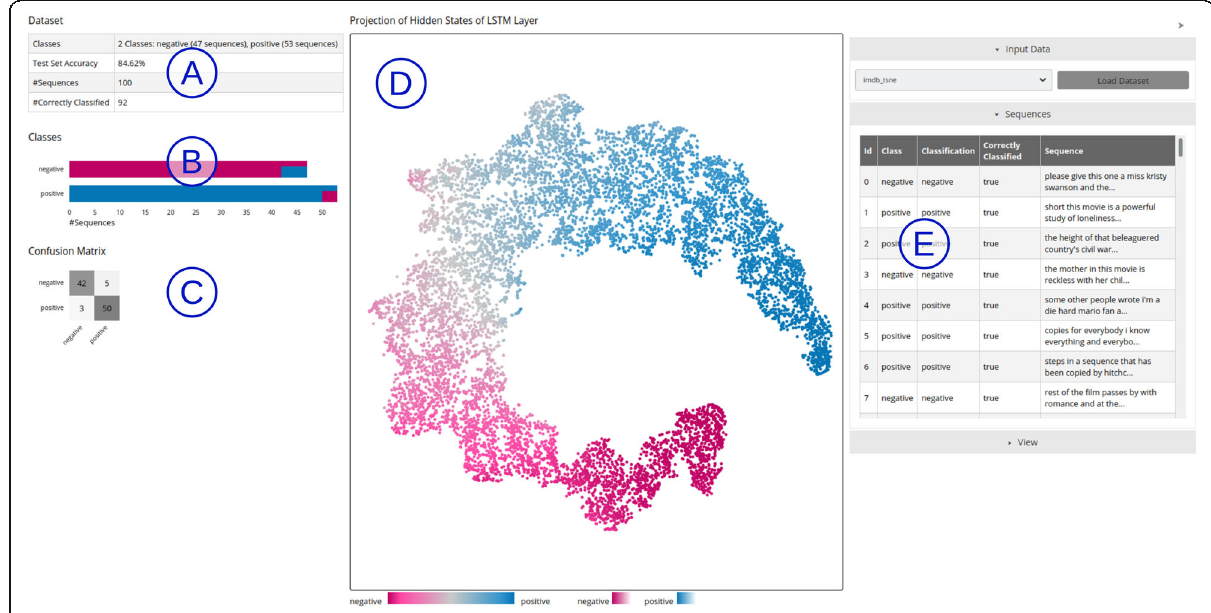
Fig. 1 The main view of our visual analytics approach applied to a model trained on the IMDB dataset. Some general information about the dataset is shown on the panels (A) to (E). ( A ): The number of input sequences, the classes, and how well the sequences were classified; ( B ): Visualizations of the different classes to compare the number of input sequences that were correctly classified; ( C ): This information is also visible in the form of a confusion matrix; ( D ): At the center, the projection of all hidden states produced by the network for all input sequences is visible; ( E ): On the right side, a list of all sequences allows the selection of a sequence for further exploration. Underlying data source: IMDB as